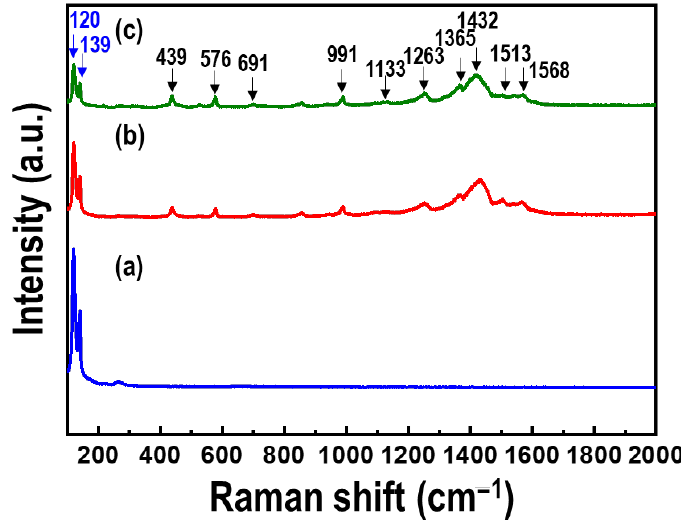
Figure 6. Raman spectra of ( a ) Te nanorod arrays, and PEDOT/Te composite films with polymeri- zation time of ( b ) 15 s and ( c ) 30 s.